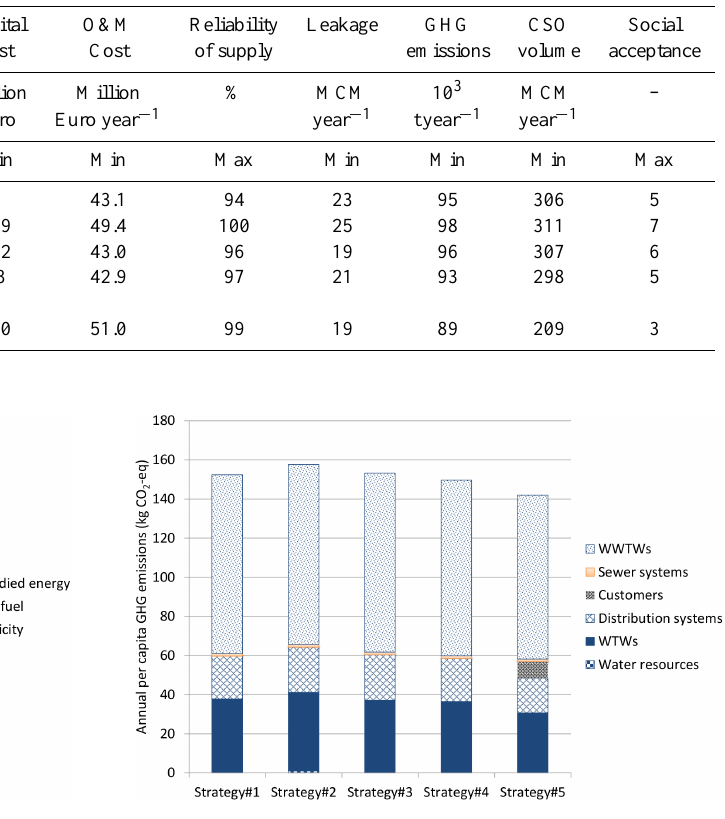
Figure 4. Contribution of three sources of GHG emissions towards annual average of per capita GHG emission in the main UWS com- ponents for the BAU.